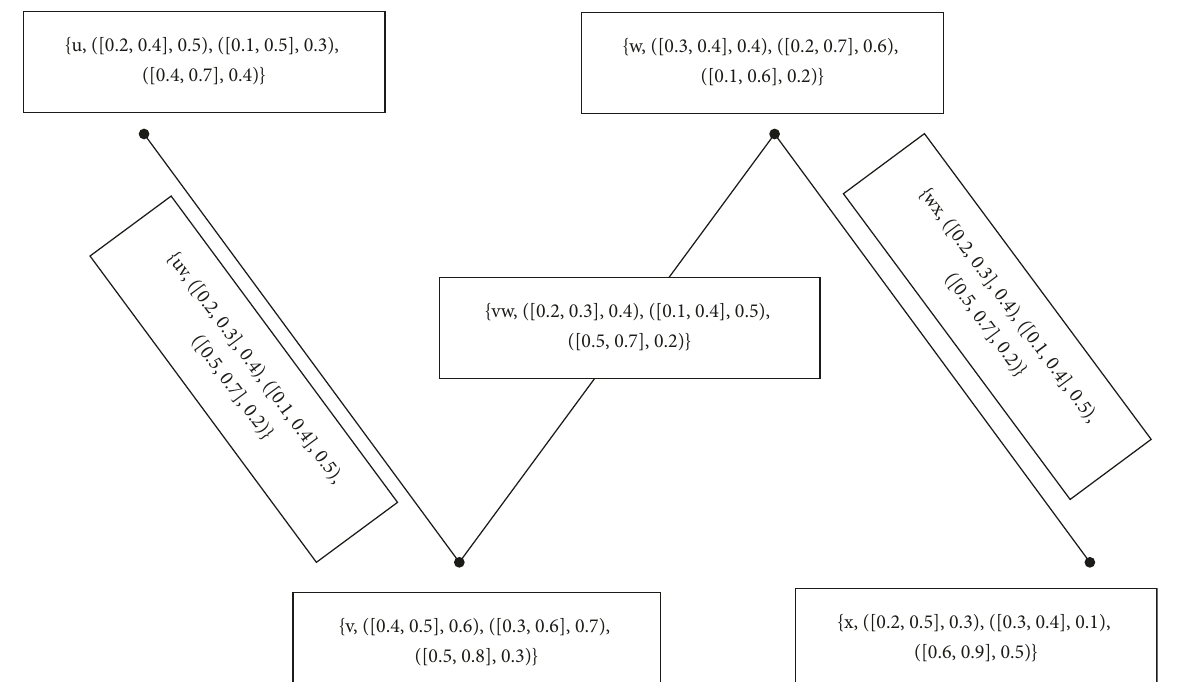
Figure 5: G is both NEI-NCG and NETI-NCG, but it is not